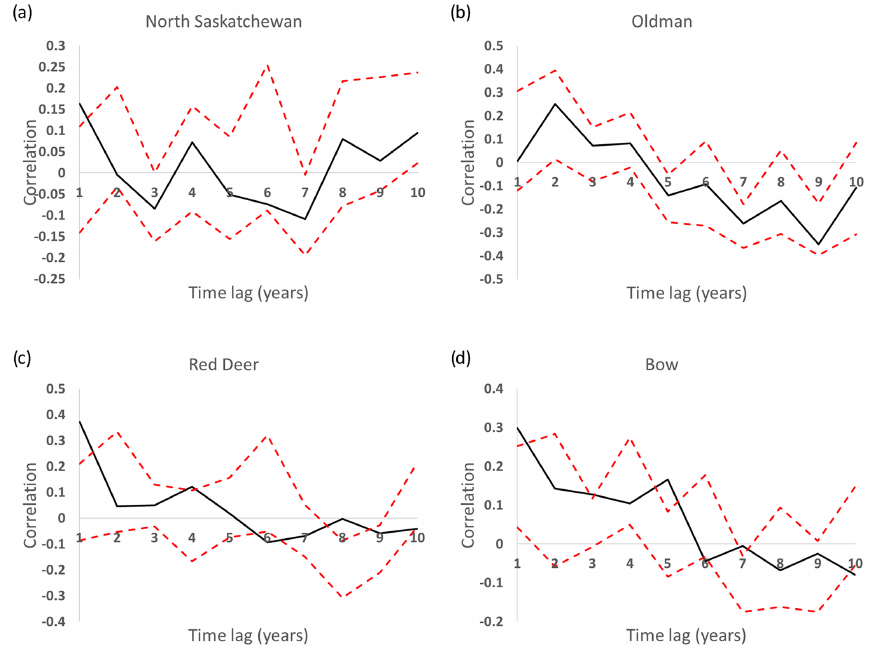
Figure 7. A comparison of autocorrelation between the 30 reconstructed flows and reference naturalized flow at a yearly time step over the reference period (1912–2001), where the dotted red lines indicate the maximum and minimum bounds of the autocorrelation values of the 30 reconstructed flows and the solid black line indicates the autocorrelation of the reference flow: (a) North Saskatchewan River, (b) Oldman River, (c) Red Deer River, and (d) Bow River.